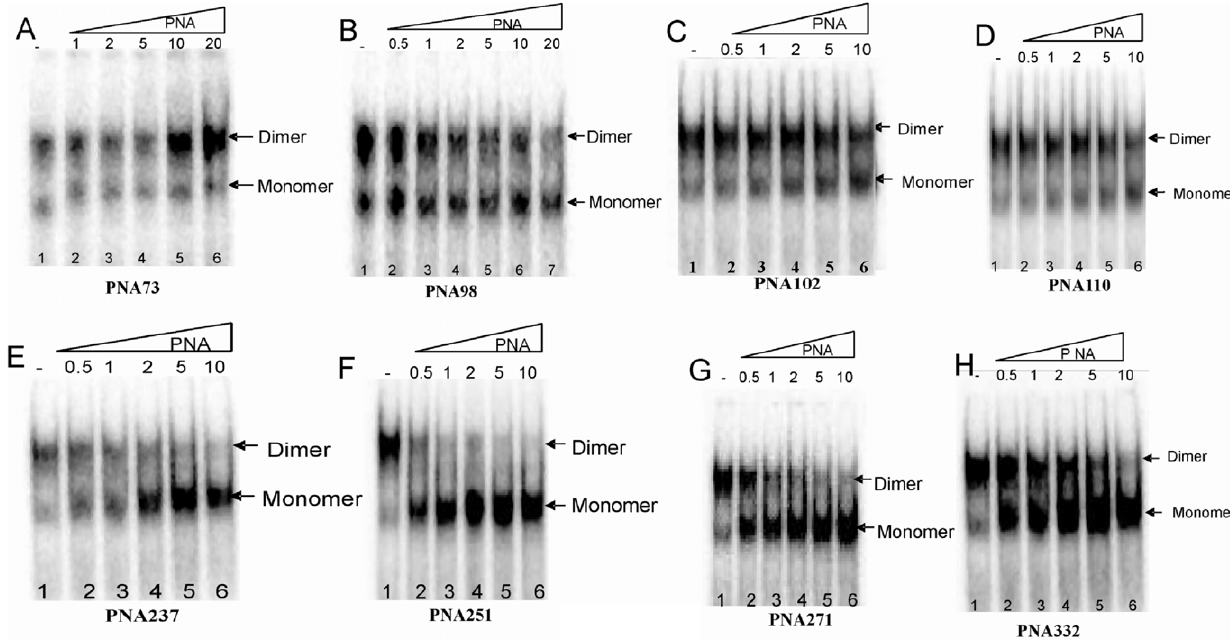
Figure 5. Effects of PNA oligomers on gel mobility of HIV-1 leader RNA (447nts). The RNA transcript was incubated in dimerization buffer (5 mM MgCl 2 ) at 65 u C in the absence or presence of increasing concentration of PNAs. The samples were analyzed on TBM gels. Each gel has the following loading pattern - Lane 1: Dimerization buffer without PNA oligomer, Lane 2–6: Dimerization buffer with the increasing template ratios, as indicated.